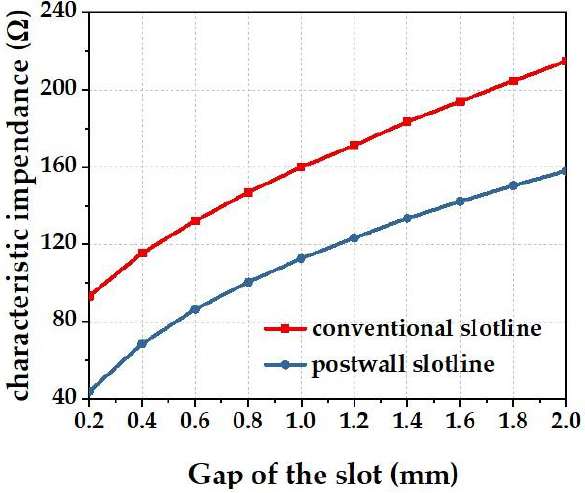
Figure 2. Characteristic impedance of the PWS and the conventional slotline.